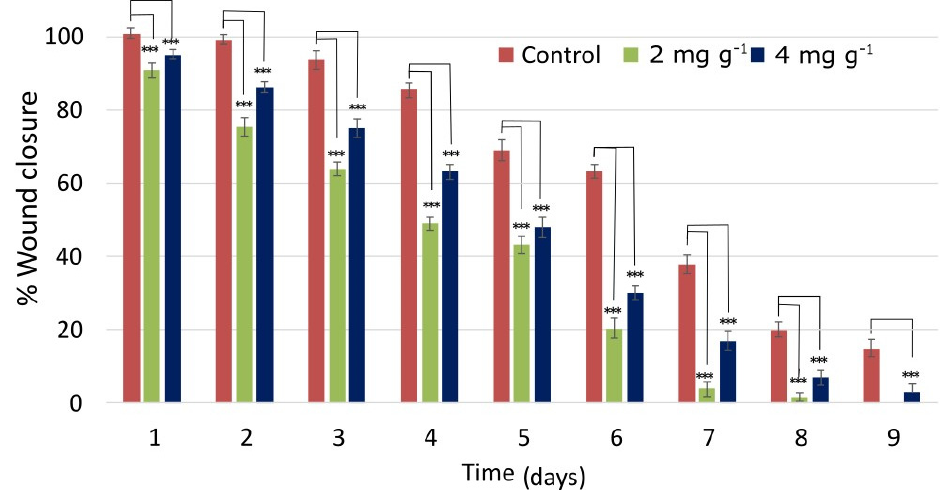
Figure 6. Graphical representation of the % wound area (compared to day 0) at different days after wound creation upon treatment with 2 and 4 mg g − 1 of Urtica dioica L. extract; statistically significant differences for p < 0.001 are denoted with ***.